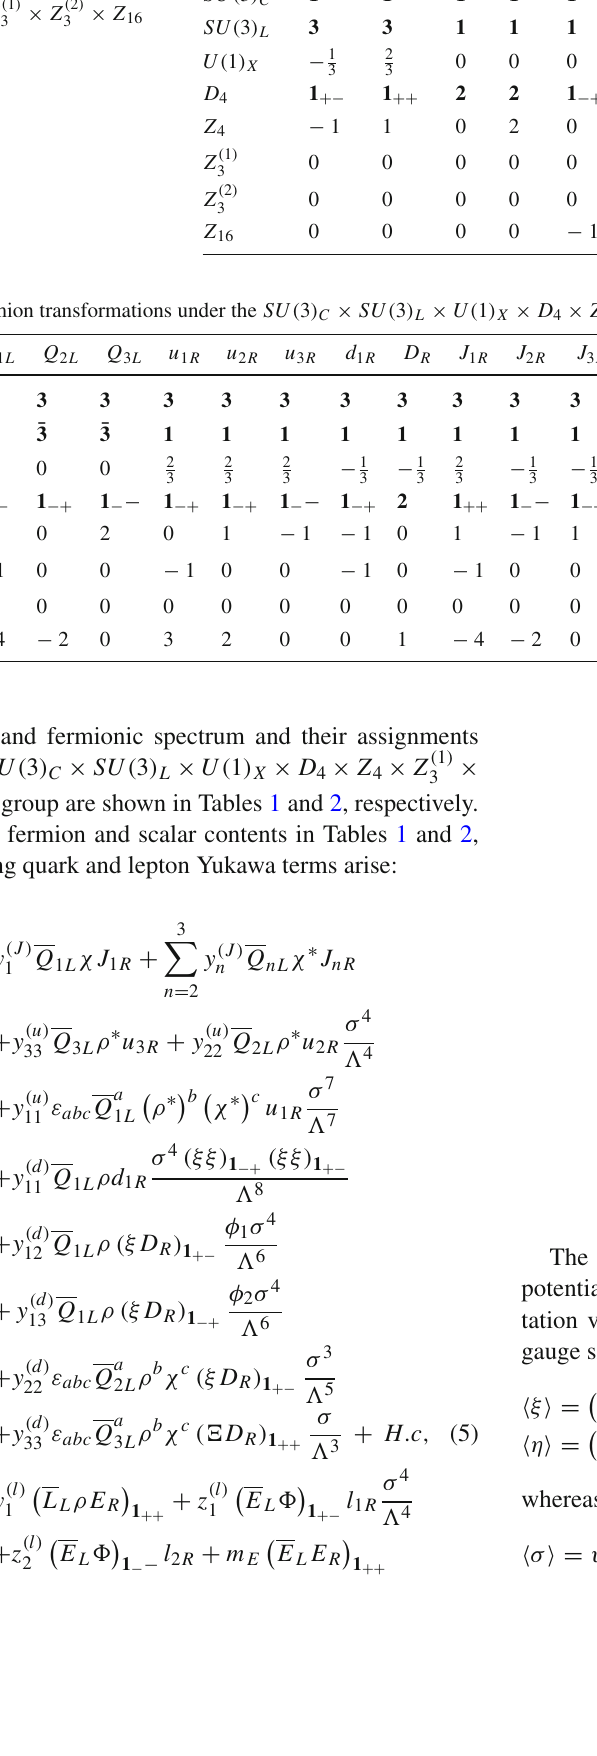
under the SU ( 3 ) C × SU ( 3 ) L × U ( 1 ) X ×